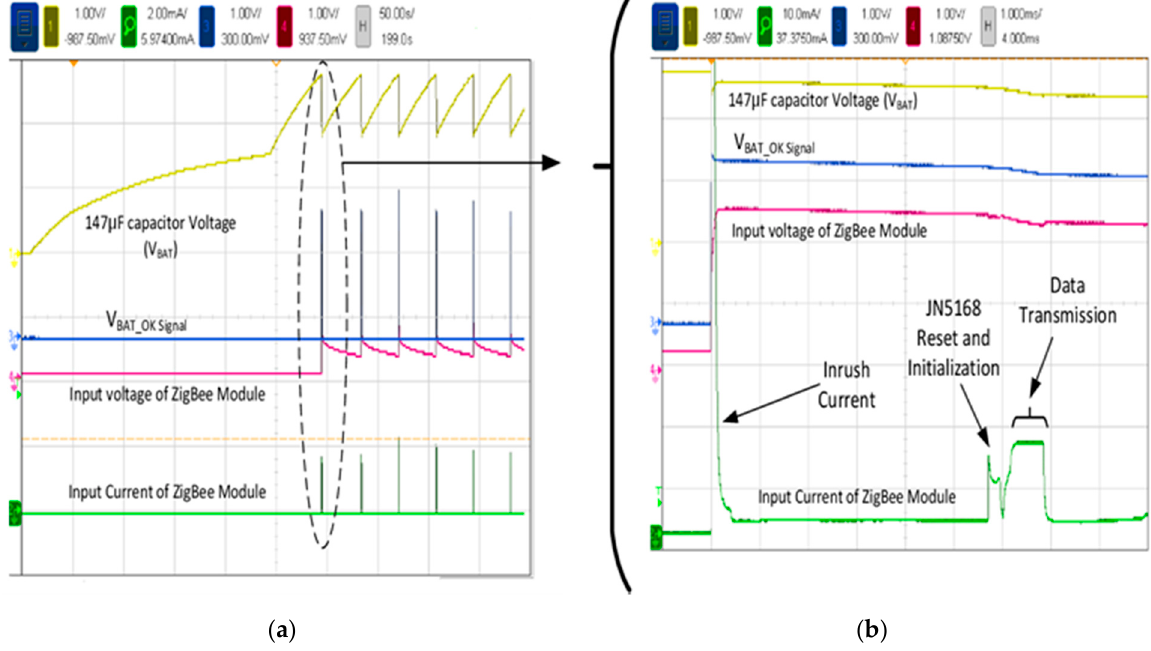
Figure 11. Charging of the 147 µF capacitors by the BQ25504 converter under 1200 lx room light conditions to power the ZigBee module: ( a ) a screenshot of the test, ( b ) a zoomed-in screenshot of the test.